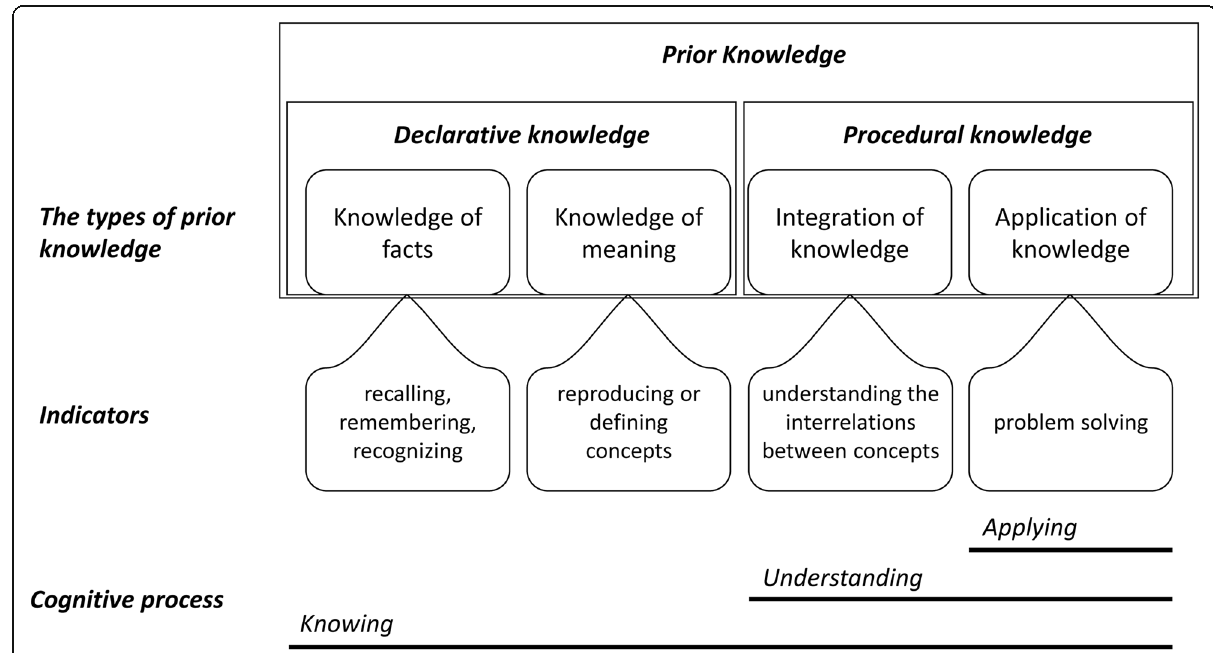
Fig. 1 Prior knowledge model (Hailikari et al.,